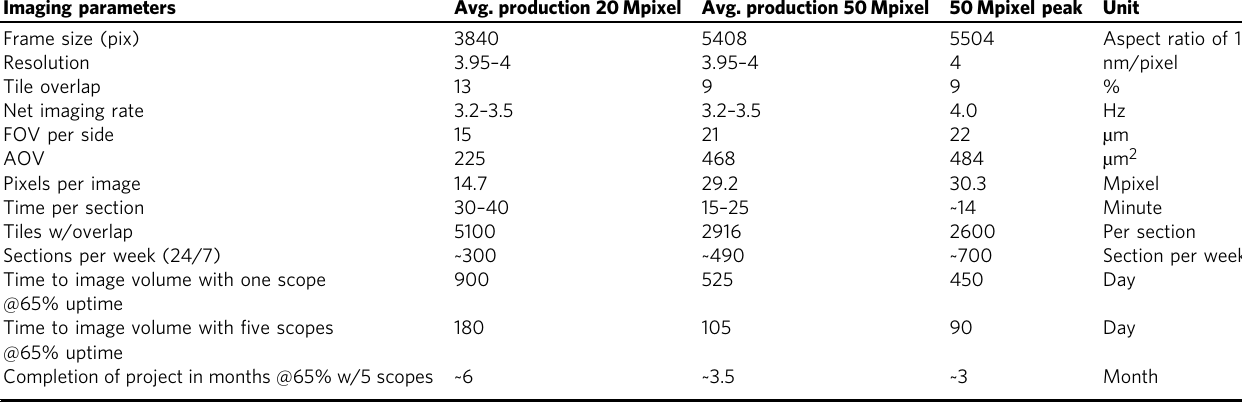
Table 1 Performance metric during 1 mm 3 production for 20 MP and 50 MP cameras. Imaging parameters